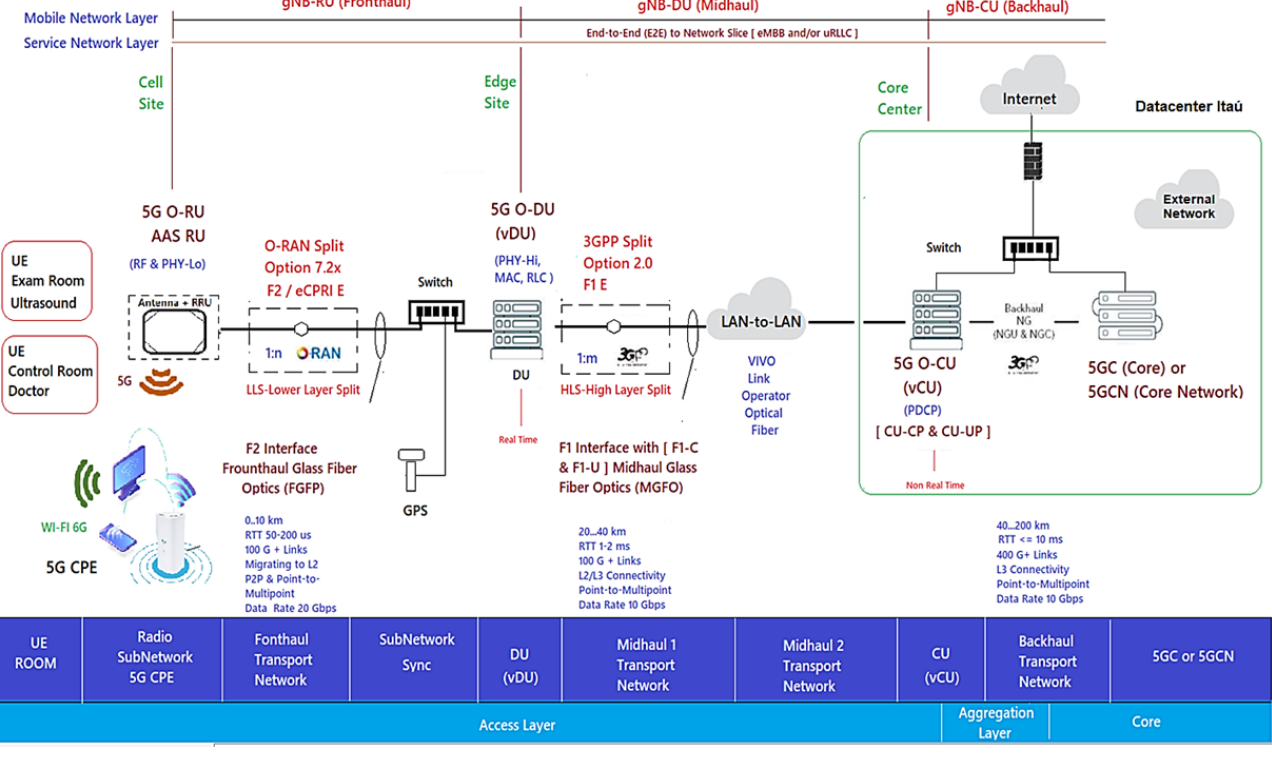
Figure 3. Architecture of the 5G xHaul network of the Inovac OpenCare5G with O-RAN OAM, complete vRAN in the infrastructure, mobile and services layers. Based on